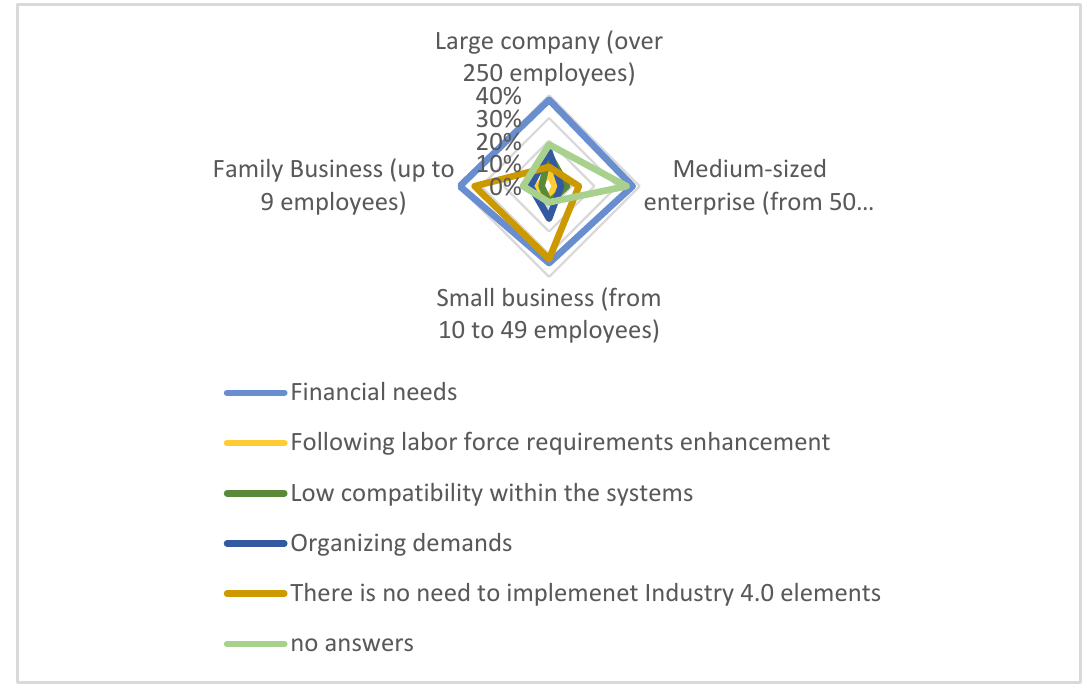
Figure 7. Education focus with respect to Industry 4.0.